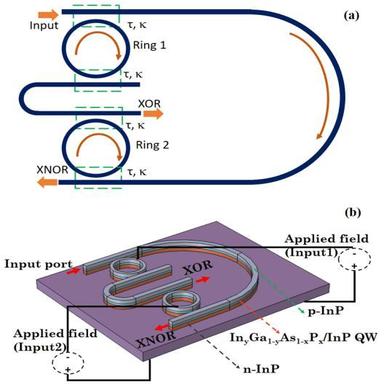
(a) Parallel triple ring MRR configuration for OR and AND gate realization. (b) Perspective view of OR AND gate based on EA MRR.